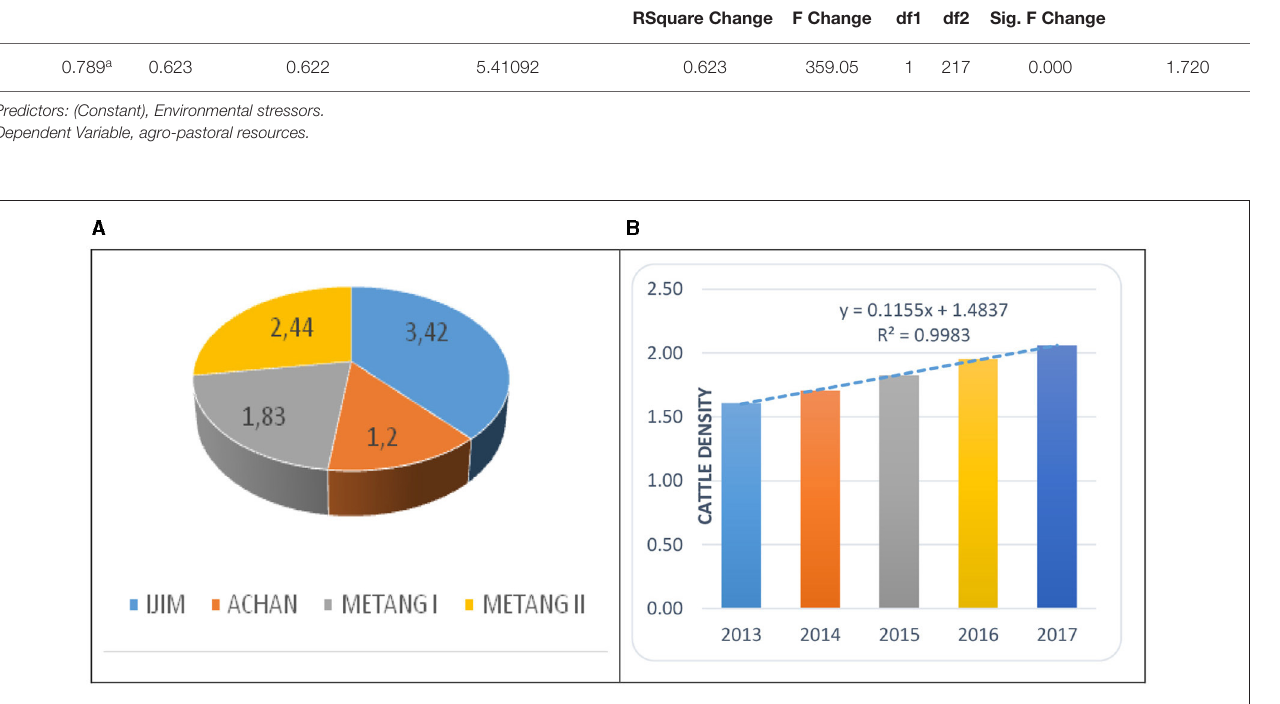
Frontiers in Sustainable Food Systems |